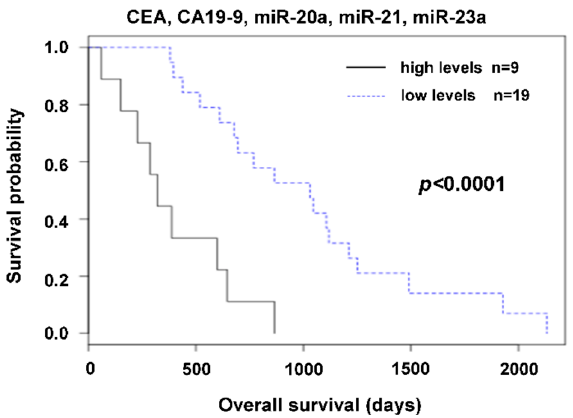
Figure 5. Combining CEA, CA19-9 with miR-20a, miR-21, and miR-23a. Patients with a very high value of any one of CEA, CA19-9, miR-20a, miR-21, or miR-23a had significantly shorter survival than those who had all the mentioned markers under the cut-off value.